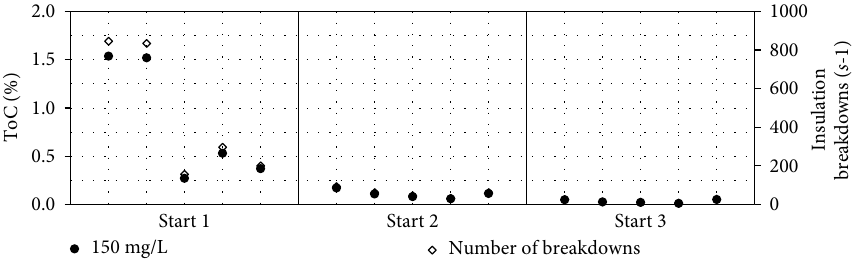
Figure 9: Percentage time of conduction for lubricant mixed with aluminium powder at concentration of 150